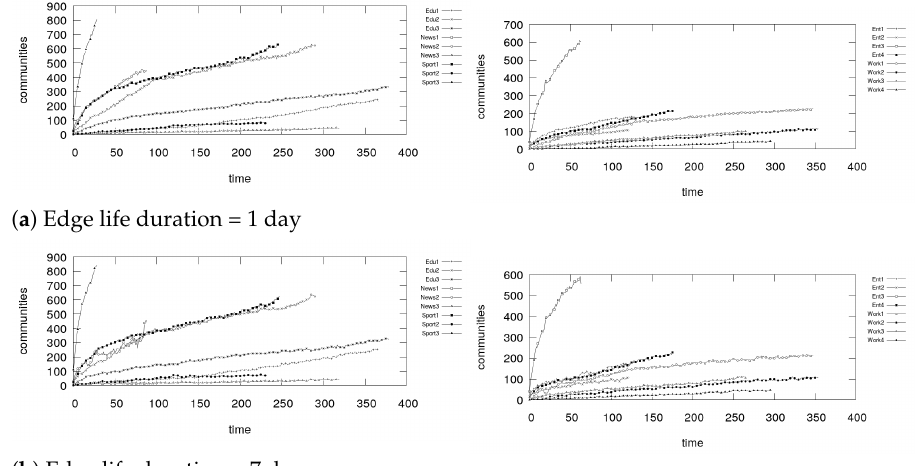
Figure 4. Number of communities detected by